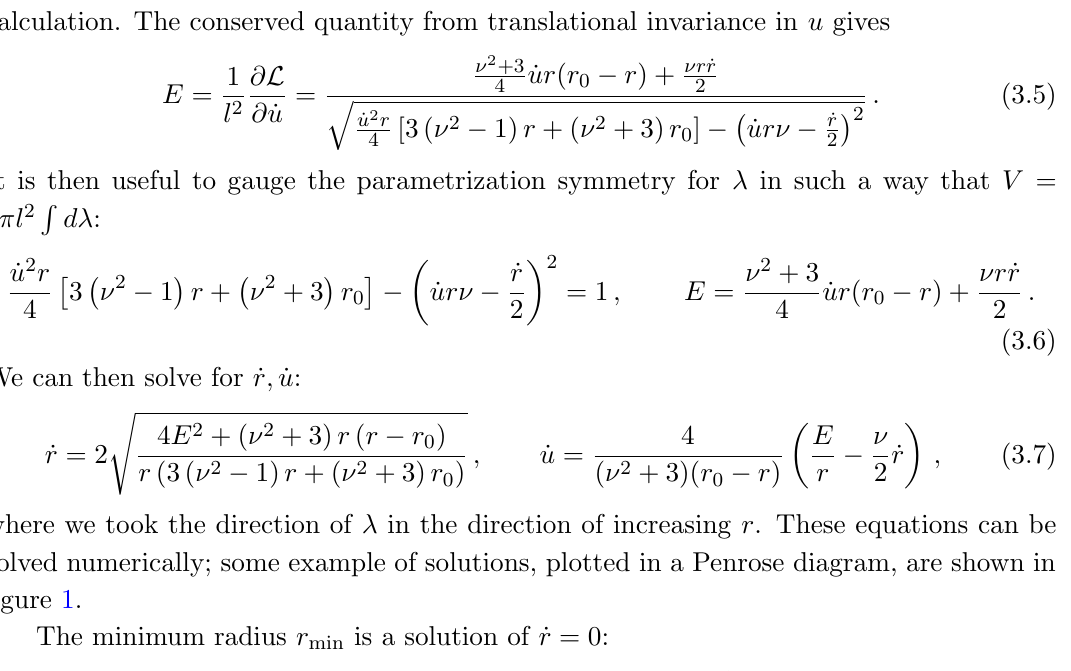
, corresponds to the large t b 2